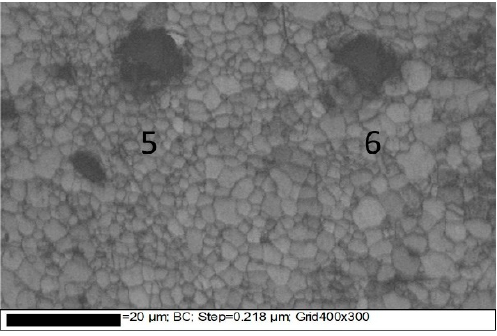
Figure 9. EBSD band contrast map of the area around indents 5 and 6 on line 1. The non-indexed dark spots correspond to the indent locations.